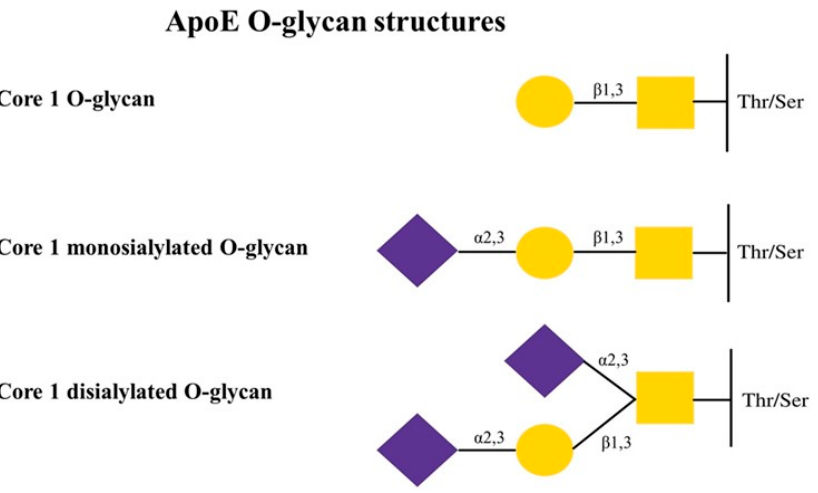
Figure 3. Typical O-glycan structures of human ApoE. Figure 3. Typical O ‐ glycan structures of human ApoE. Neu5Ac—sialic acid (N ‐ acetylneu ‐ Figure 3. Typical O ‐ glycan structures of human ApoE. Neu5Ac—sialic acid (N ‐ acetylneu ‐ Figure 3. Typical O ‐ glycan structures of human ApoE. Neu5Ac—sialic acid (N ‐ acetylneu ‐ Figure 3. Typical O ‐ glycan structures of human ApoE. Neu5Ac—sialic acid (N ‐ acetylneu ‐ raminic acid), Gal—galactose, GalNAc—N ‐ acetylgalactosamine, Ser—serine, Thr—threo ‐ raminic acid), Gal—galactose, GalNAc—N ‐ acetylgalactosamine, Ser—serine, Thr—threo ‐ raminic acid), Gal—galactose, GalNAc—N ‐ acetylgalactosamine, Ser—serine, Thr—threo ‐ raminic acid), Gal—galactose, GalNAc—N ‐ acetylgalactosamine, Ser—serine, Thr—threo ‐ GalNAc—N-acetylgalactosamine, Ser—serine, Thr—threonine. Modifi- nine. Modification based on Flowers et al. [8]. nine. Modification based on Flowers et al. [8]. nine. Modification based on Flowers et al. [8]. nine. Modification based on Flowers et al. [8]. cation based on Flowers et al.